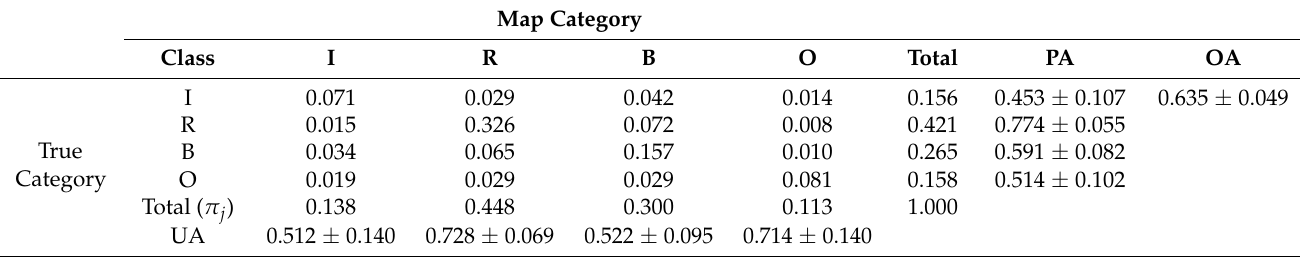
Table 5. Confusion matrix of DI-based classification results (I: Institution; R: Residence; B: Business; O: Open Space). UA: users accuracy; PA: producers accuracy; OA: overall accuracy; π _j is the class proportion according to the classified